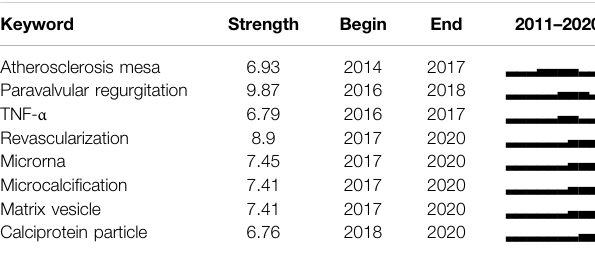
TABLE 8 | Top 8 keywords with strongest citation